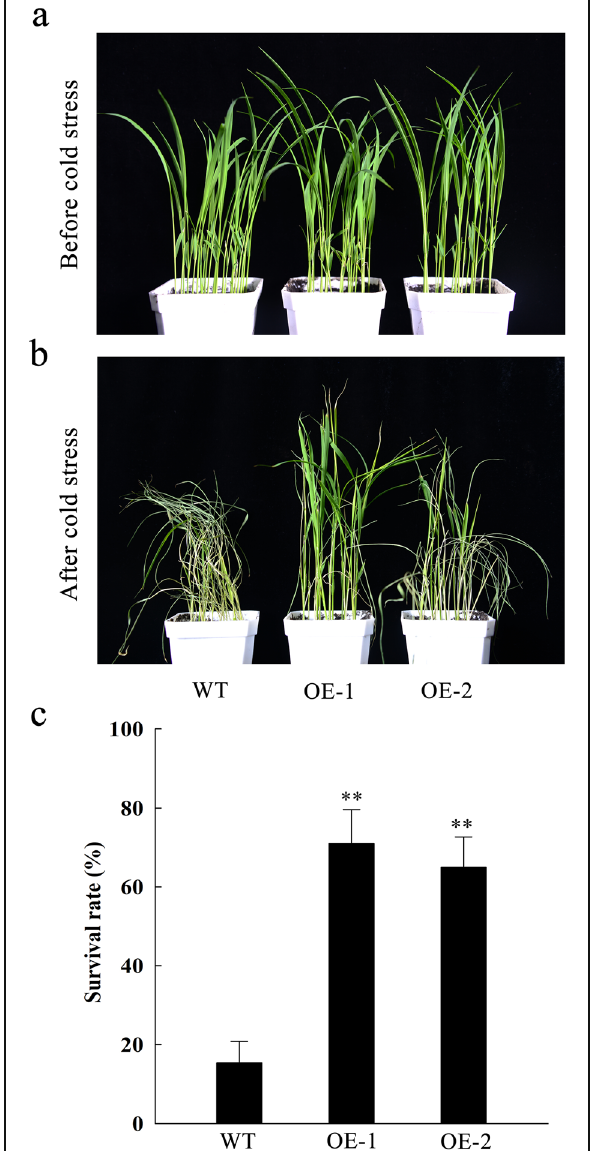
Fig. 4 OsGATA16 overexpression phenotype and survival rate after exposure to cold stress. a Wild-type (WT) and OsGATA16- overexpression (OE) lines at the 3-leaf seedling stage, prior to exposure to cold stress (8°C). b WT and OE seedlings after cold stress exposure and recovery at room temperature. c Survival of OE and WT plants after exposure to cold stress. Data represent the mean±SE from five replicates. Asterisks indicate significant differences in survival rate (Student ’ s t-test,